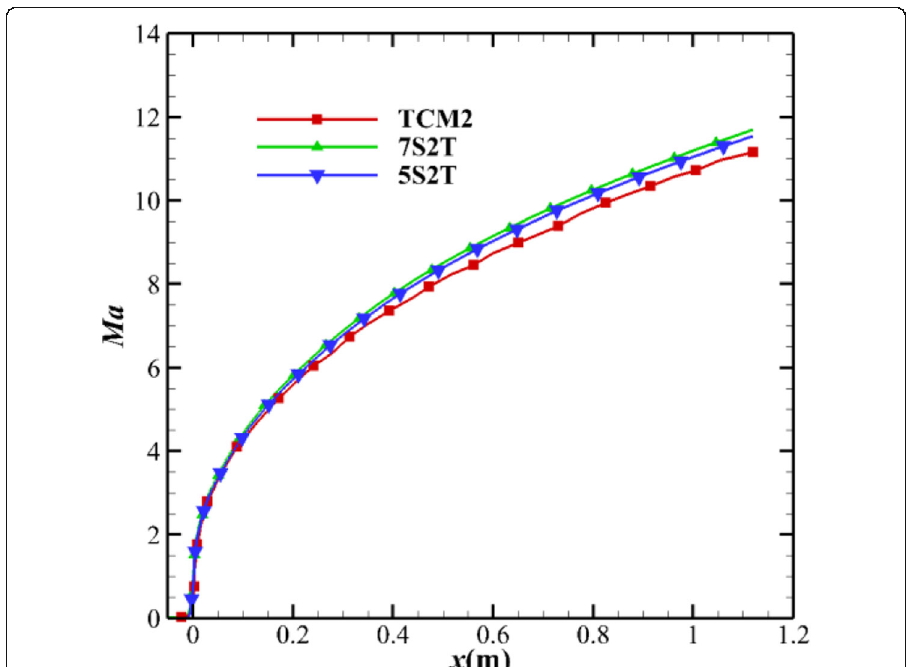
Fig. 4 Comparison of the centerline Mach number distributions